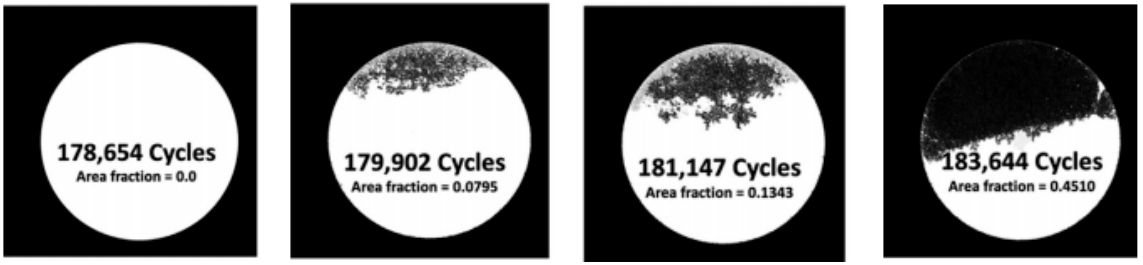
Figure 14. Area fraction of projected crack surface by utilizing X-ray tomography for sample HCF- Table 13. The summary of novel research on the ZK60 magnesium alloys.